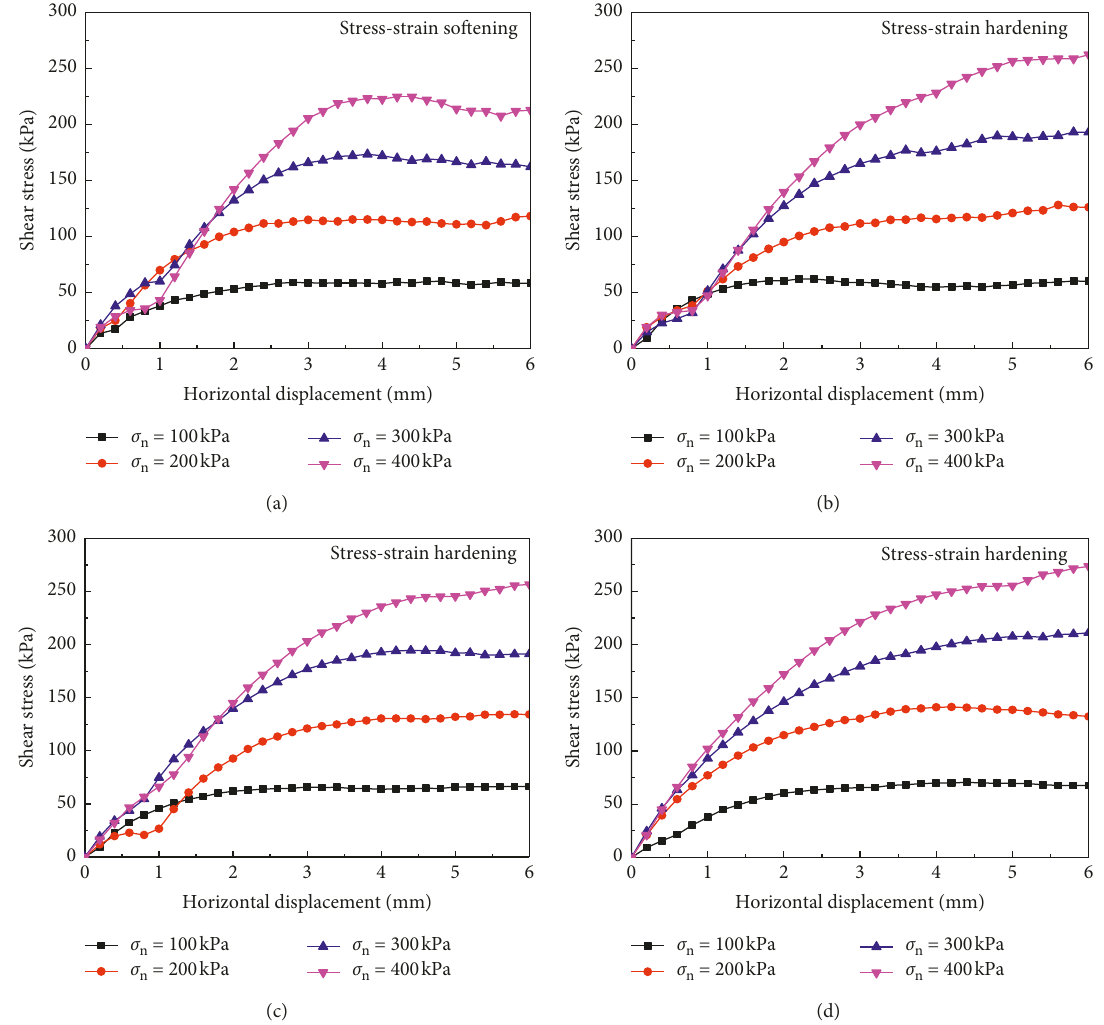
Figure 4: Shear stress-horizontal displacement curves. Rubber content: (a) 0%; (b) 5%; (c) 10%; (d) 15%.